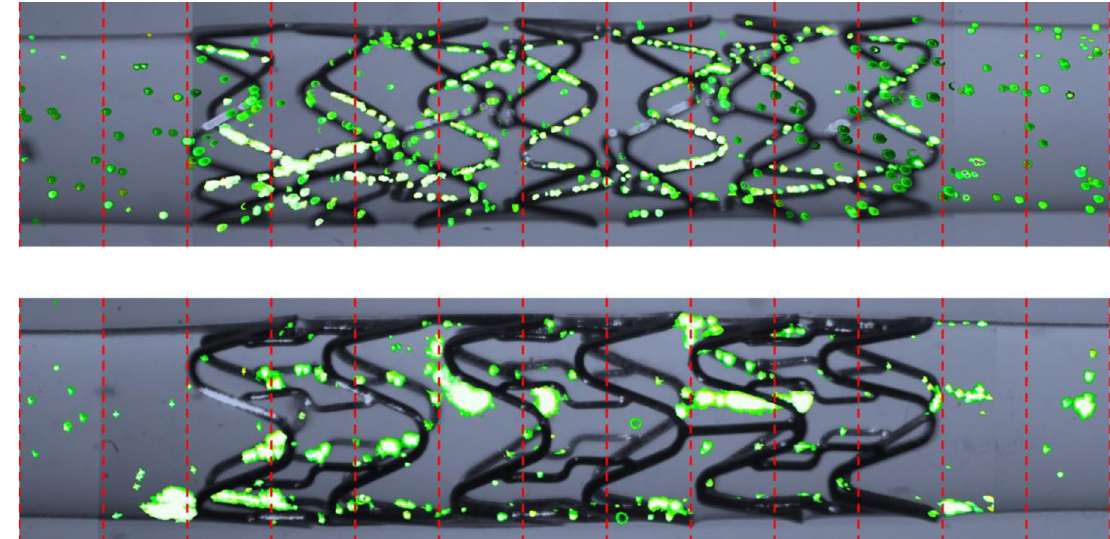
Fig 5. Locations of particle accumulation within coronary stents. After cessation of flow, accumulated particles (green) within coronary stents deployed in model vessels were imaged and counted within 1 mm segments (red lines) in order to assess whether the workflow can be used to analyse particle accumulation. No pattern in the location or distribution of particles throughout each model was seen, with the exception of the Chroma and Matrix stents shown here, in which accumulation was almost exclusively seen immediately up or downstream of struts. Top: Chroma stent. Bottom: Matrix